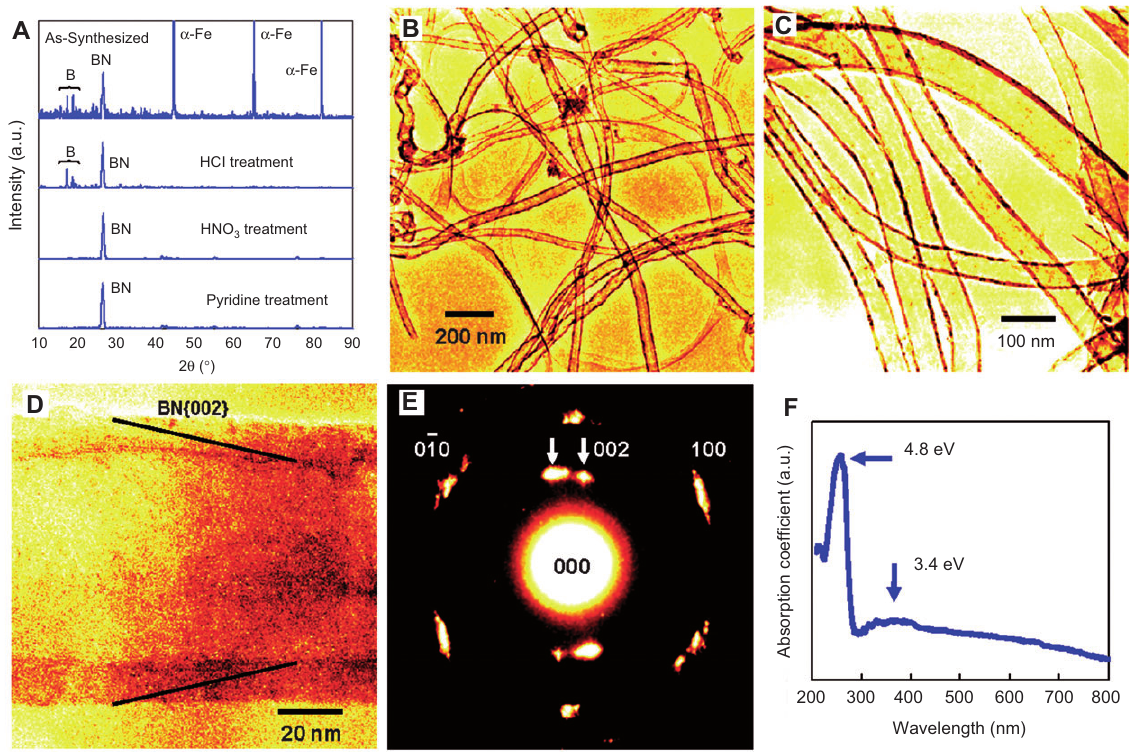
Figure 20 (A) XRD patterns of samples after synthesis, HCl treatment, HNO image of the sample after pyridine treatment. (D) Enlarged image of BN nanotube with cup-stacked structure. (E) Electron diffraction pattern of (D). (F) Optical absorption spectrum of BN